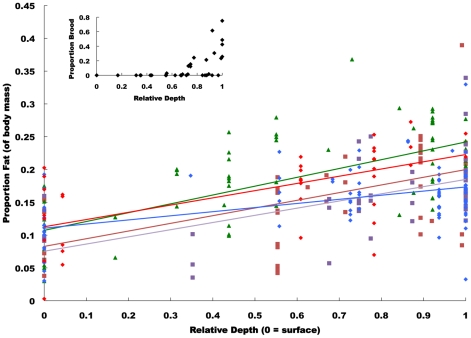
The relationship between individual fat content (as a proportion of total dry body mass) and the relative depth at which the individual was collected (1 being deepest and 0 being the surface) for five colonies of Dinoponera australis (each colony is coded by a different color).Colonies differed in the slope of the relationship between fat content and relative depth (F4,267 = 3.41, P = 0.01), but the relationship is highly significant (F1,267 = 137.93, P<0.0001) and colonies did not differ in average individual fat content (F4,267 = 1.27, P = 0.28). The inset shows brood (larvae and pupae) as a function of depth; only the deepest chambers contained brood.